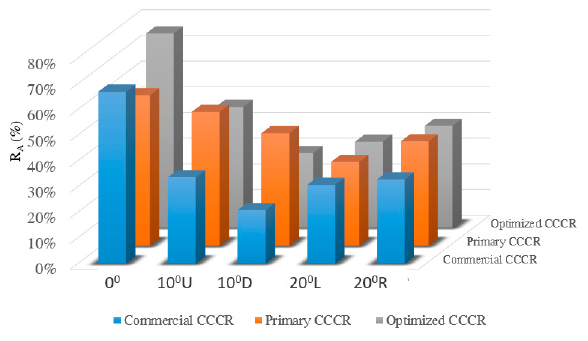
Figure 17. Intensity distributions and R I for 0° incident light beam on anterior, central and posterior regions of the commercial CCCR, which are shown in ( a )–( c ) respectively, and those of the optimized CCCR are shown in ( d )–( f ). Figure 18. Comparison of the reflection coe ffi cient R I of commercial CCCR, primary CCCR and Figure 18. Comparison of the reflection optimized CCCR. . coefficient R I of commercial CCCR, primary CCCR and optimized CCCR.